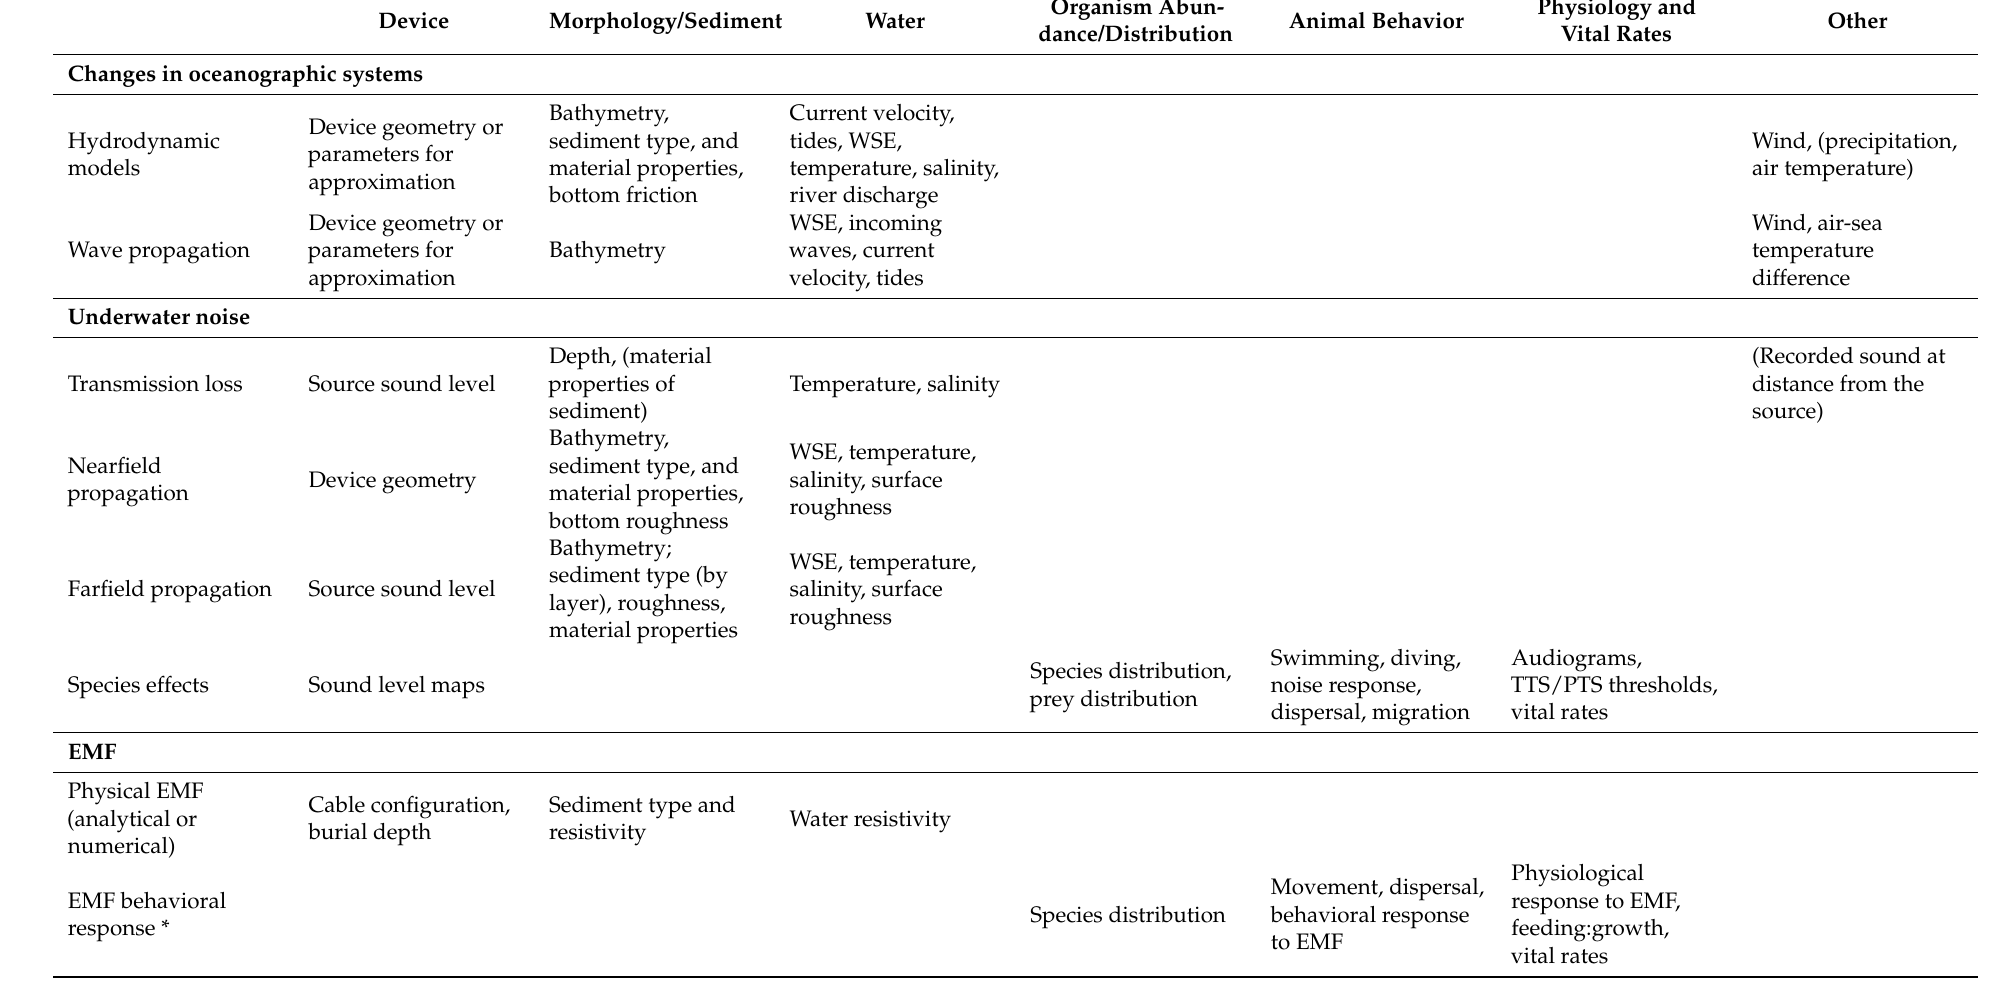
Table 3. Summary of information needs by model type. Not all parameters are needed for all models of a stressor; parameters used less frequently are indicated